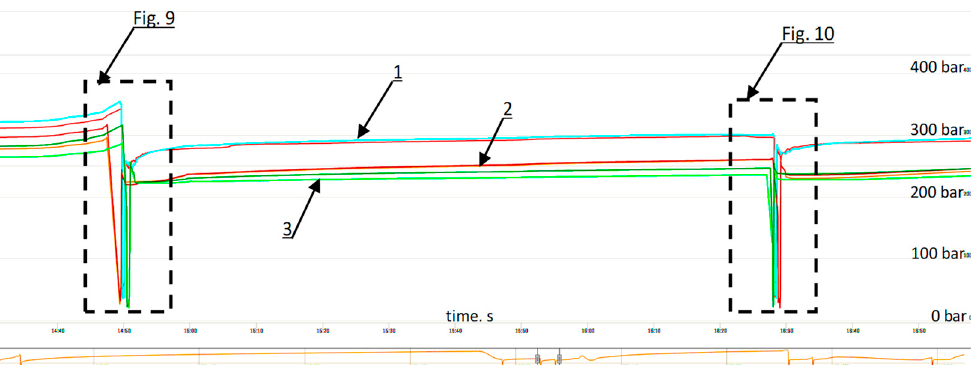
Figure 8. The course of the pressure value after the installation of the automatic expansion system for the selected powered support: 1, powered support in longwall no. 43; 2, powered support in longwall no. 44; 3, powered support in longwall no. 45.